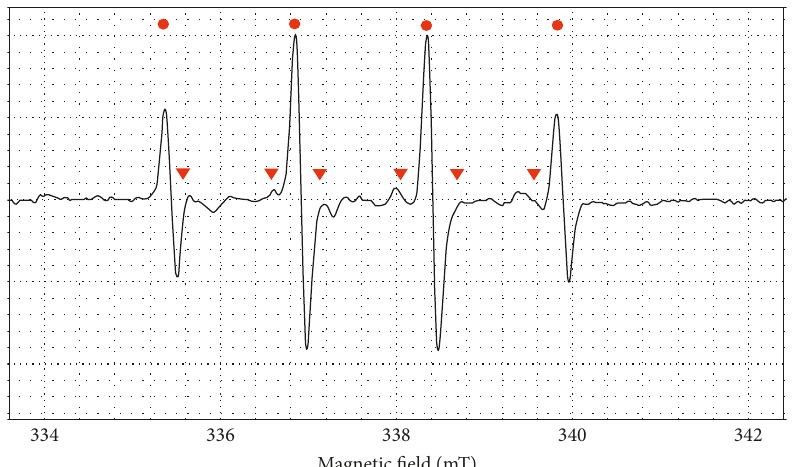
4 . Experimental conditions: